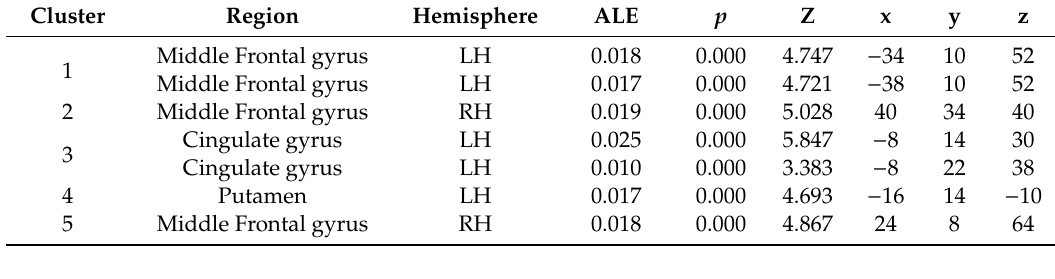
Table 5. Results of ALE meta-analysis on deactivation in Alcohol Use Disorder. For each cluster region label hemisphere, the cluster size (mm 3 ), ALE value, and MNI coordinates are provided. LH = left hemisphere; RH = right hemisphere.